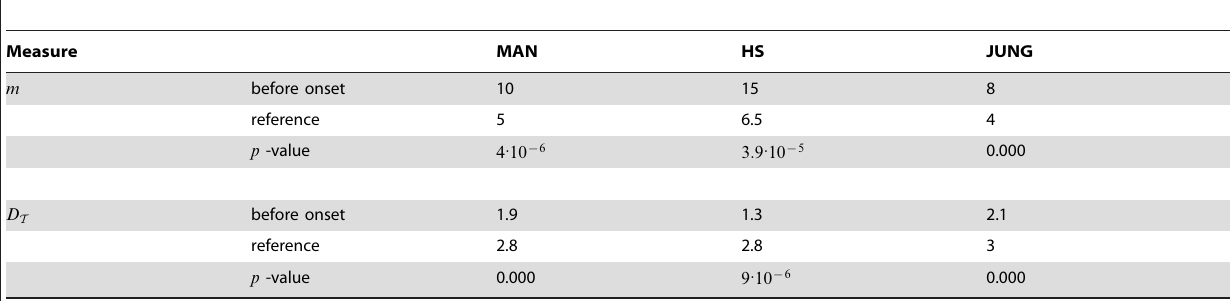
Table 2. Median values of the optimal embedding dimension m and transitivity dimension D T for the considered data sets before transition point onset and for the reference